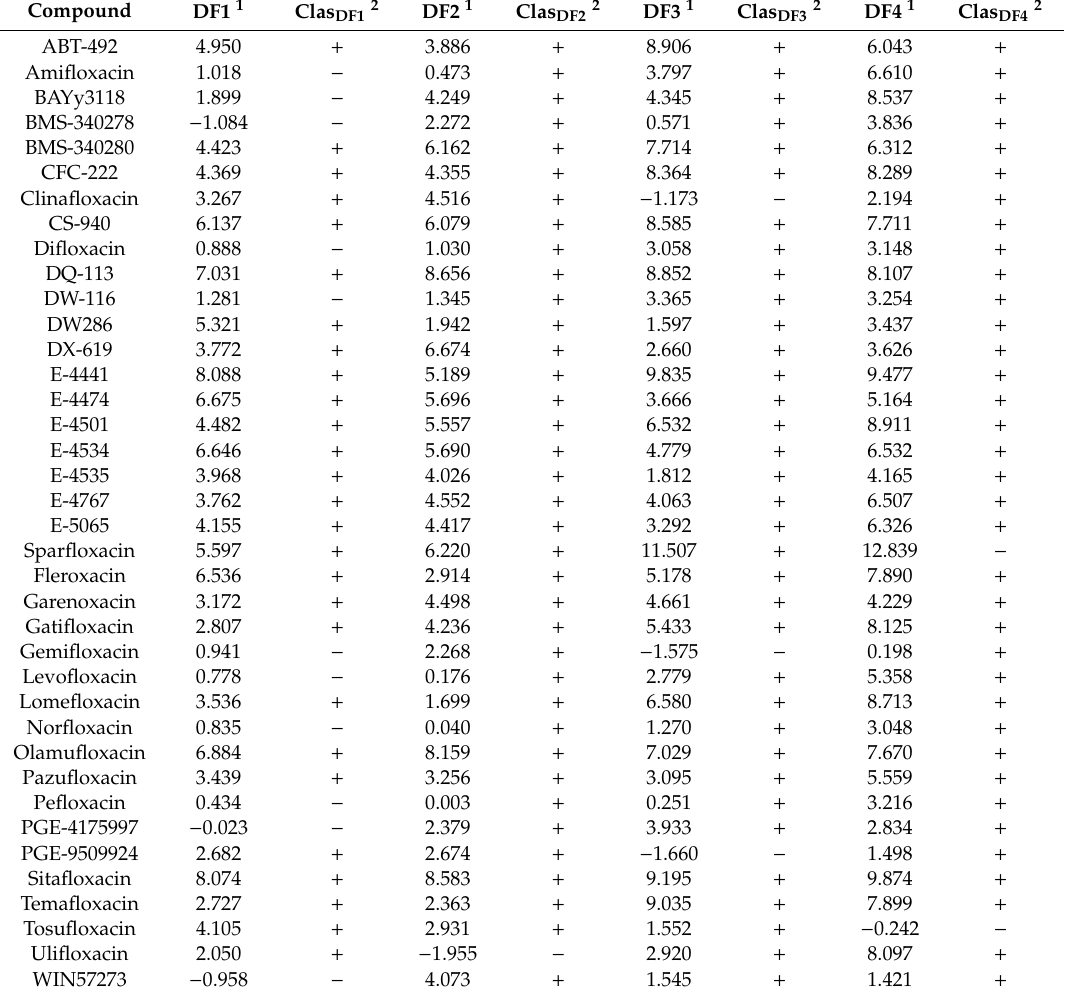
Table 5. Results obtained after combining LDA and PDD for DF1-4. Training group: actives. Compound